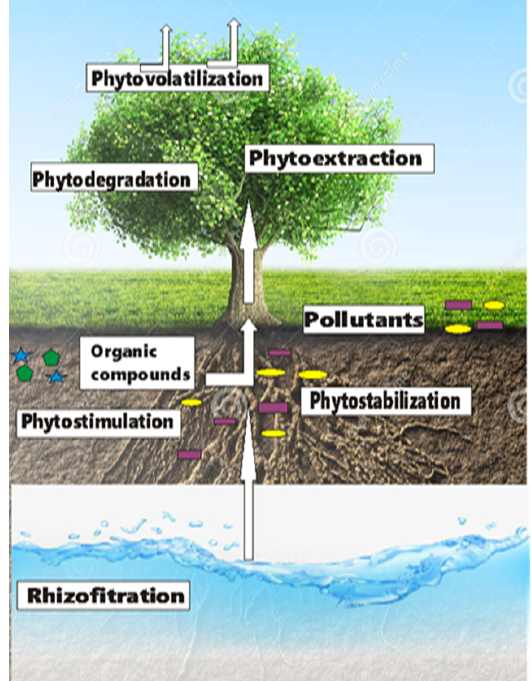
Figure 1. Phytoremediation technologies exhibited by plants